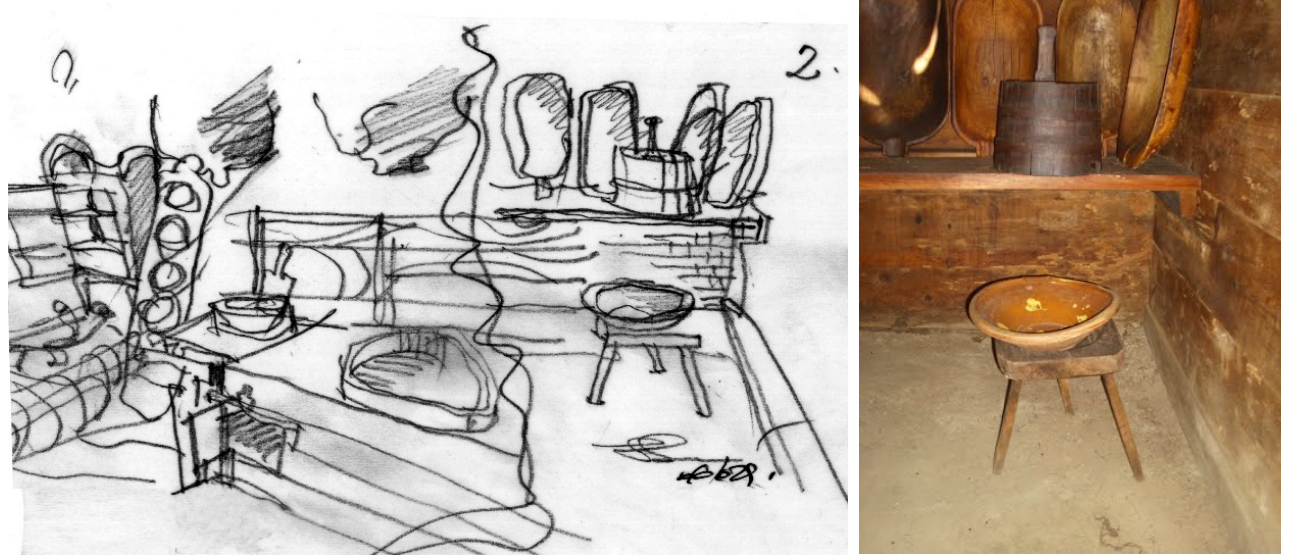
Figure 10. The interior of the Traditional Houses of the Zeta area (S. Popovic, G. Skataric, 2021). Opposite the fireplace was a space for utensils for processing milk and storing cheese—“kaduc”, “stap”, and “pucerica”. Right behind the front door was a place for a water tank—a wooden tub “kaca sa cepcijom”. The bread was baked in large pots; it could weigh up to 10 kilos. Some believed that “there is no more beautiful and tasty bread in Montenegro.” Around the fireplace are arranged big chairs “stolovace” with small chairs next to a low table “sofra” and wooden cutlery (sometime of copper), and wine was drunk with jugs called “krcag” and brandy with bottles (“boca”).